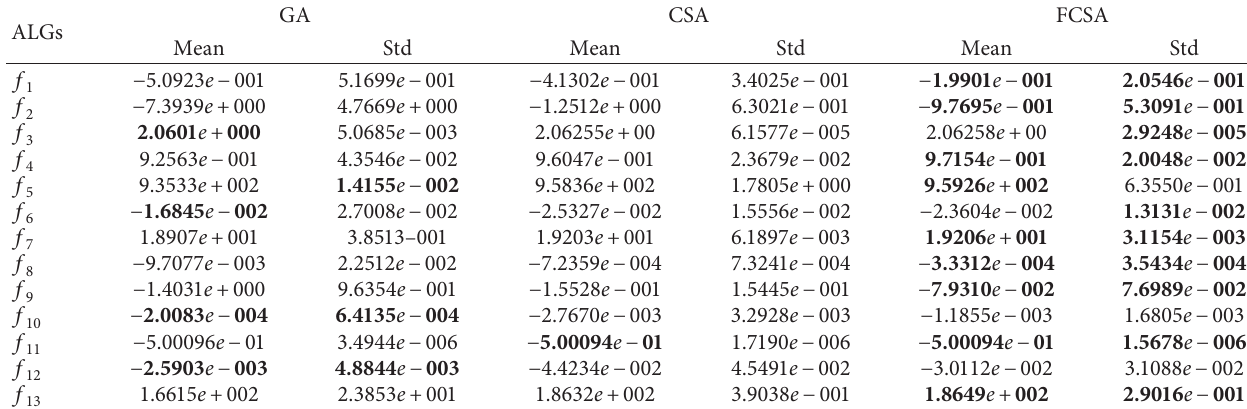
Table 4: Results of GA, CSA, and FCSA when D � 2.